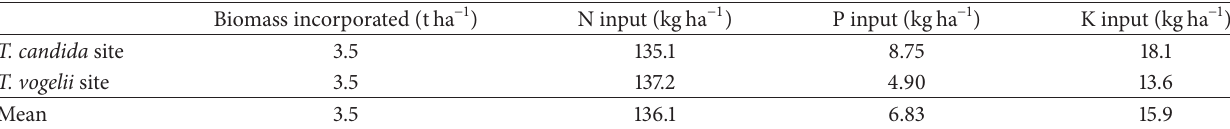
Table 4: The amount of Tephrosia standing biomass incorporated into the soil and the corresponding N, P, and K inputs. Biomass incorporated (tha − 1